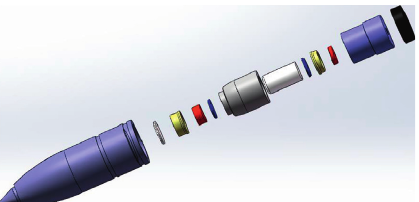
Figure 5: The structure of 125mm EPW (three dimensional).